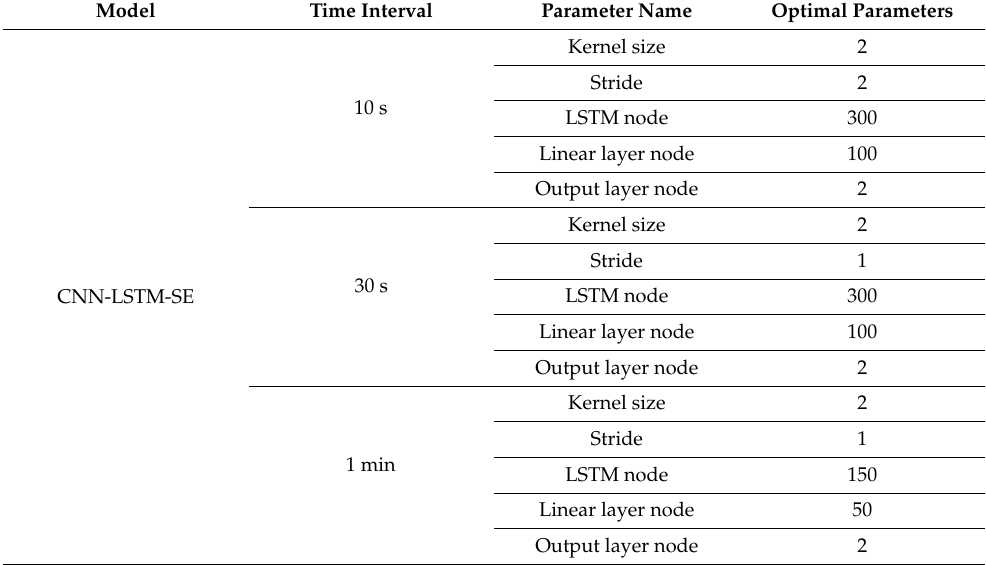
Table 1. Model parameter settings.